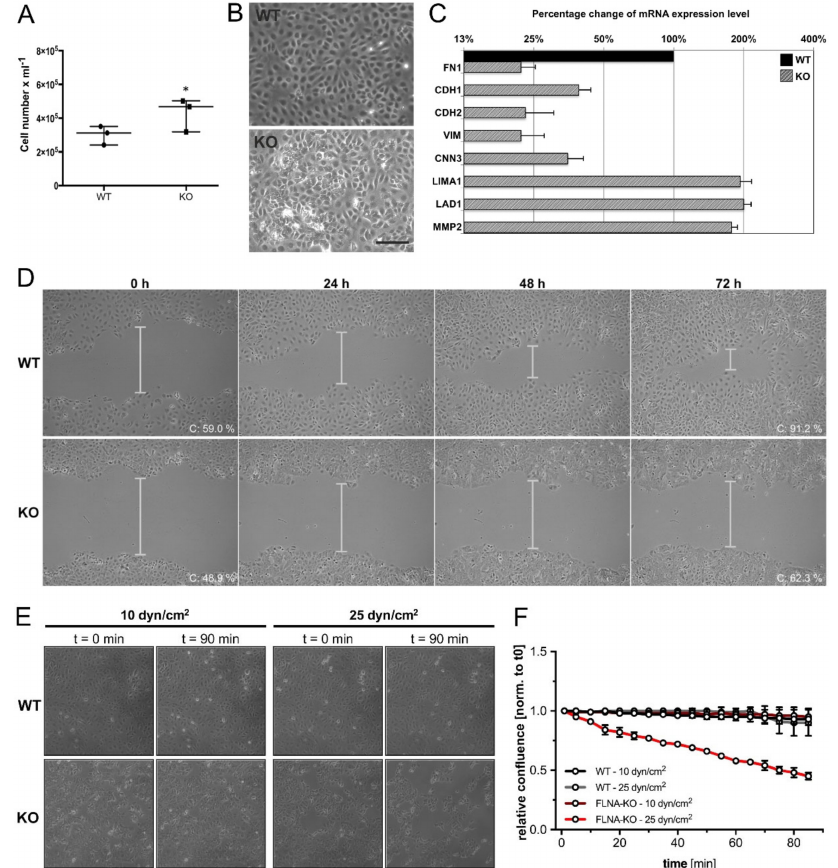
Figure 4. Characterization of FLNA-deficient TCam-2 cells. ( A ) FLNA-deficient TCam-2 cells (KO) show significantly (* p < 0.05) accelerated cell proliferation, compared to TCam-2 wildtype cells (WT), indicated by higher cell counts after 24 h. ( B ) In comparison to TCam-2 WT cells that show a primarily two-dimensional growth behavior, FLNA-KO cells are characterized by the tendency to grow three-dimensionally before confluence when plated on culture dishes for 24 h. Scale bar: 200 µ m. ( C ) Deletion of FLNA is associated with altered mRNA levels of genes encoding cytoskeletal proteins, cell adhesion proteins and proteins involved in cell migration. Data are represented as percentage change of mRNA expression level of TCam-2 WT cells (black bar = 100%) compared to FLNA-KO cells (gray bars). Samples were pipetted in duplicate, and qPCR runs were performed twice to generate mean values of two clones + SEM. ( D ) Representative phase contrast images of a scratch assay performed with TCam-2 WT and FLNA-KO cells after 0, 24, 48 and 72 h post scratching. Percentage of confluence ( C ) at 0 and 72 h is indicated. Supplementary Videos S1 and S2 show the corresponding time lapse recordings for TCam-2 WT and FLNA-KO cells. ( E ) Shear stress experiment with TCam-2 WT and FLNA-KO cells. Representative phase contrast images depict detachment behavior of cells at two di ff erent shear rates (10 and 25 dyn per cm 2 ) at two di ff erent time points (0 and 90 min). Supplementary Videos S3–S6 show the corresponding time-lapse recordings. ( F ) Relative confluence of WT and KO cells after 90 min shear-force exposure (10 and 25 dyn per cm 2 ). Experiments were performed